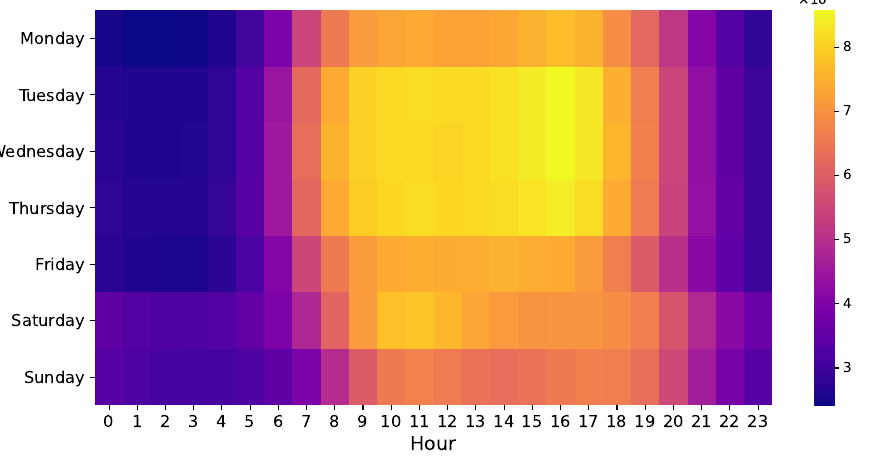
Figure 4. The mobile phone activity distribution by days of week and hours based on the 2017 data set. Mondays and Fridays are not so bright as the other workdays, probably because of Easter Monday and Good Friday that are holidays in